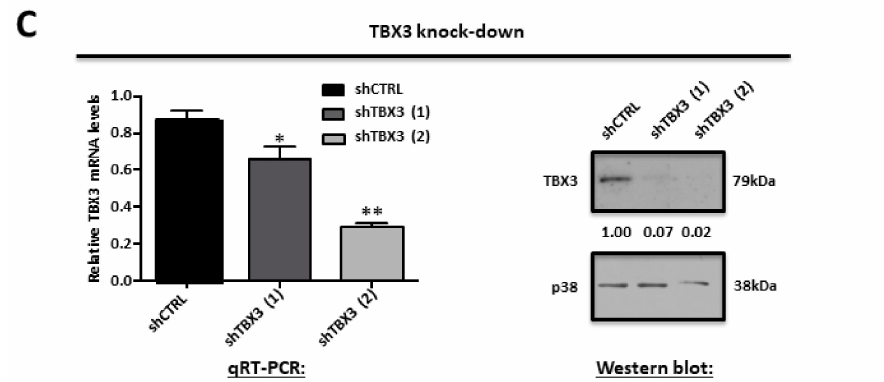
Figure 1. TBX3 is overexpressed in embryonal rhabdomyosarcoma (ERMS). ( A ) Total RNA and protein were extracted from RMS cell lines (ERMS: RD, FLOH-1 and ARMS: RH30 and AXOH-1) and normal muscle myoblasts (C2C12). (Left) qRT-PCR was performed on reverse transcribed RNA using primers specific to TBX3, TBX3 + 2a and GUSB / GusB (housekeeping gene) and mRNA levels were normalised to GUSB / GusB and quantified relative to C2C12. (Right) protein extracts were subjected to Western blot analysis with antibodies specific to TBX3 and p38 (loading control). ( B , C ) Establishment of ERMS cell culture models in which TBX3 was either stably overexpressed or knocked down in the RD cell line. mRNA and protein from ( B ) RD Flag-Empty, Flag-Tbx3 or Flag-Tbx3 + 2a cell lines and ( C ) RD shCTRL and shTBX3 clones were subjected to (left) qRT-PCR with primers specific to TBX3 and GUSB and mRNA levels were normalised to GUSB and (right) Western blotting with antibodies to ( B ) Flag-tag (representative of ectopically expressed Flag-TBX3 protein) and ( C ) TBX3 and p38 was used as a loading control. Densitometric readings for all Western blots were calculated relative to the p38 control. The values in the graphs represent the mean of at least three independent experiments ± SEM (* p < 0.02; ** p < 0.002; *** p <